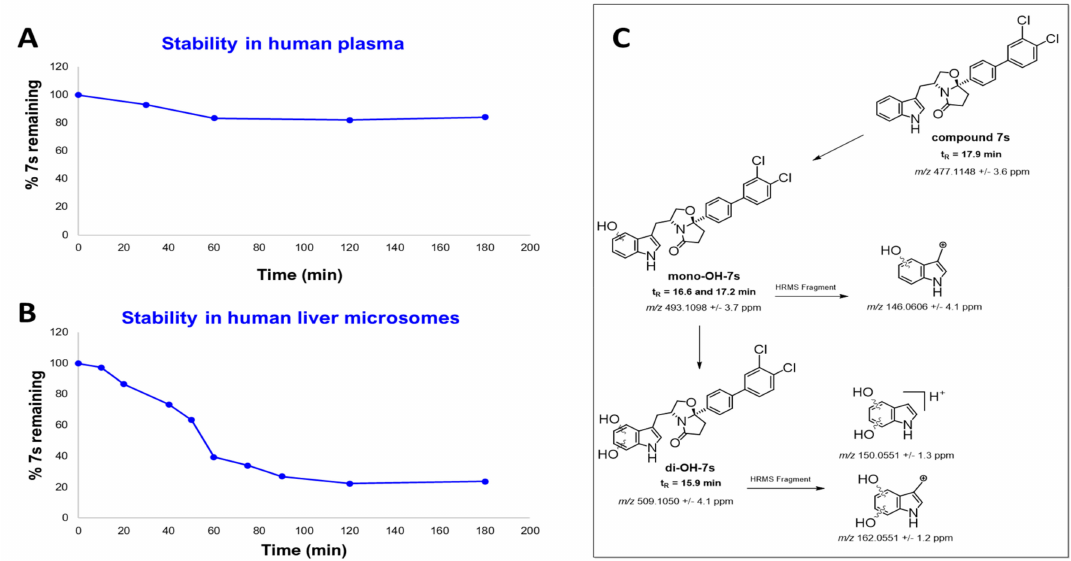
Figure 5. ( A ) Stability of compound 7s in human plasma; ( B ) stability of compound 7s in human liver microsomes; ( C ) HRMS evidence for the identification of the mono-OH-7s (major) and di-OH-7s (minor)